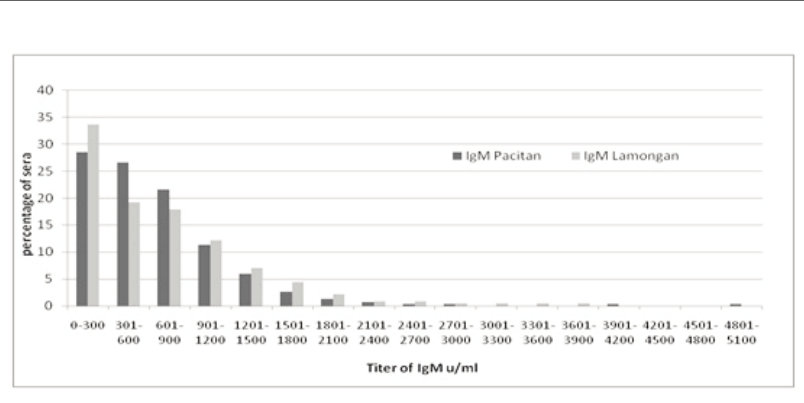
Figure 2. Distribution of serological level of IgM antibody anti PGL-1 among healthy children in endemic leprosy area in north coast (Lamongan District) and non-endemic leprosy area in south coast (Pacitan